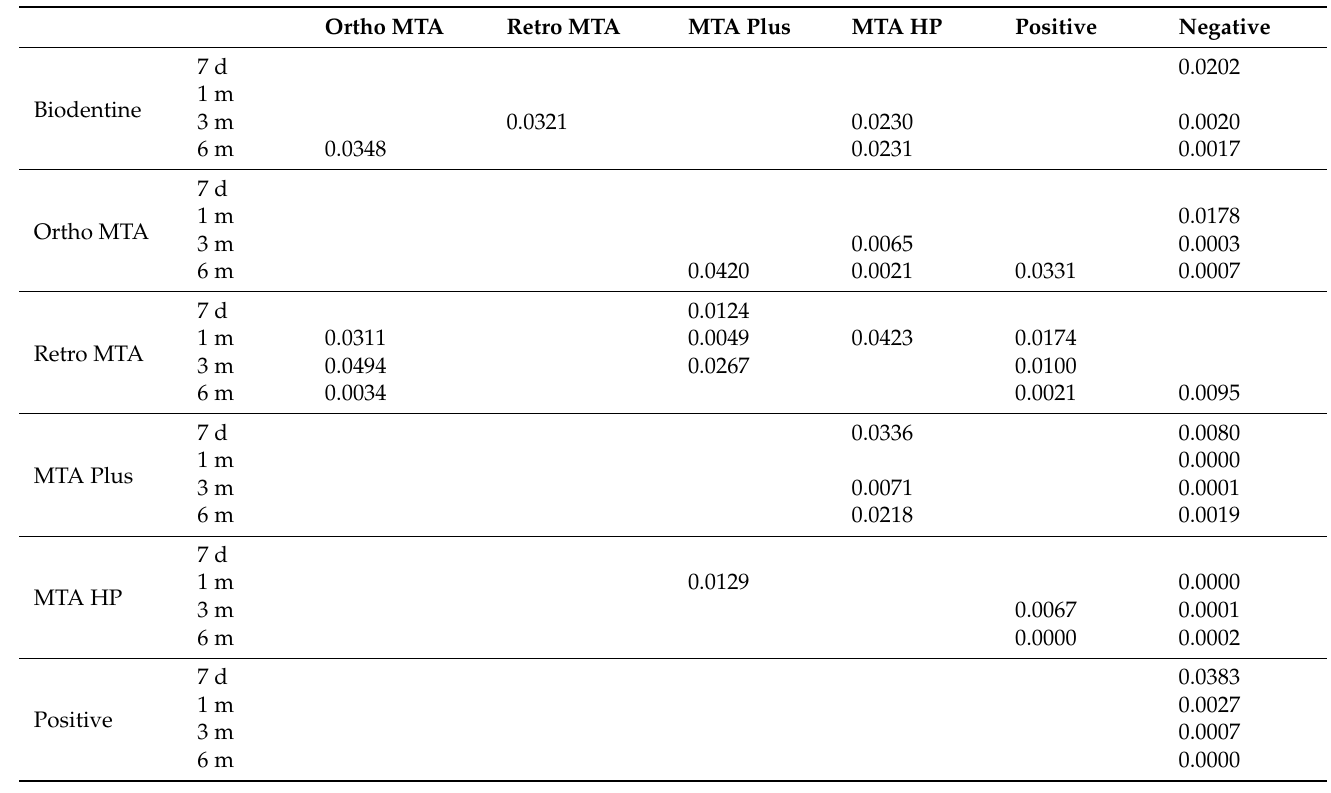
Figure 4. Mean Δ L values of tooth discolouration for different durations. Similar letters indicate statistically significant differences between different time points within a material group ( p < 0.05); Biodentine (a 0.0311; b 0.0022; c 0.0011; d 0.0448; e 0.0257); Ortho MTA (a 0.0002; b 0.0004; c 0.0002; d 0.0394); Retro MTA (a 0.0363; b 0.0486; c 0.0209; d 0.0171; e 0.0126); MTAPlus (a 0.0126; b 0.0081; c 0.0002; d 0.0012; e 0.0310); positive (a 0.0002; b 0.0002; c 0.0004); negative (a 0.0171). Table 2. p -Values obtained from comparing groups of materials at different measuring times ( p <